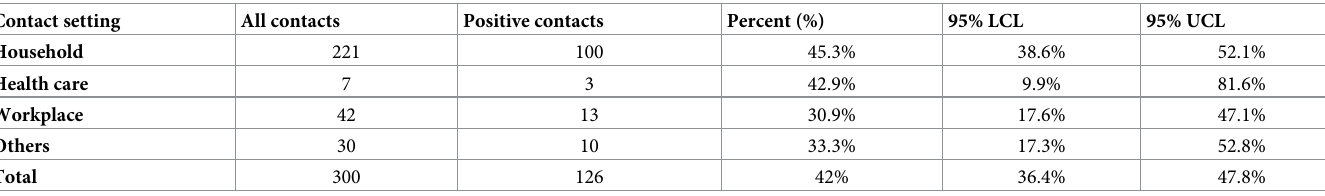
Among ten sub-cities in Addis Ababa City, the highest number of COVID-19 cases, close contacts, and close contacts tested COVID-19 positive by RT-PCR were reported from Lideta